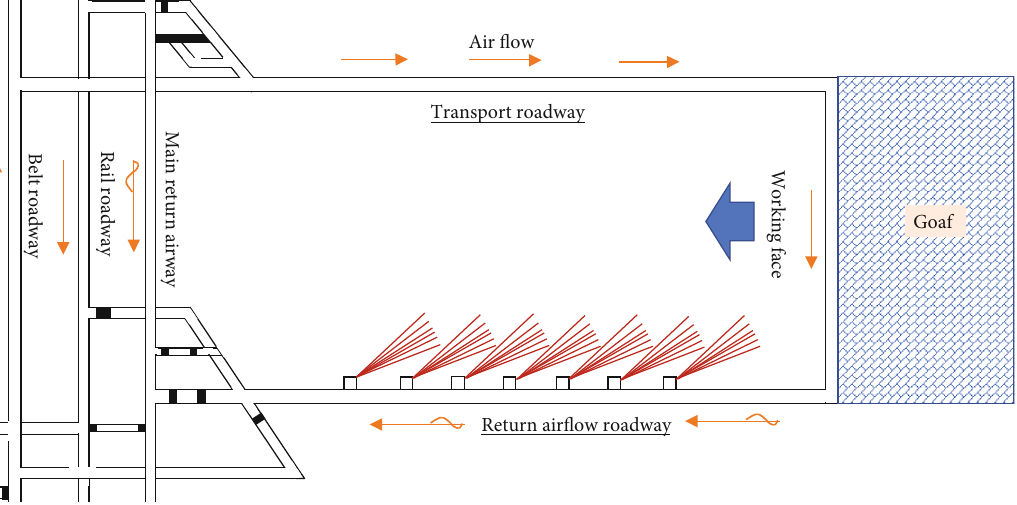
Figure 1: Schematic diagram in 7607 working face.